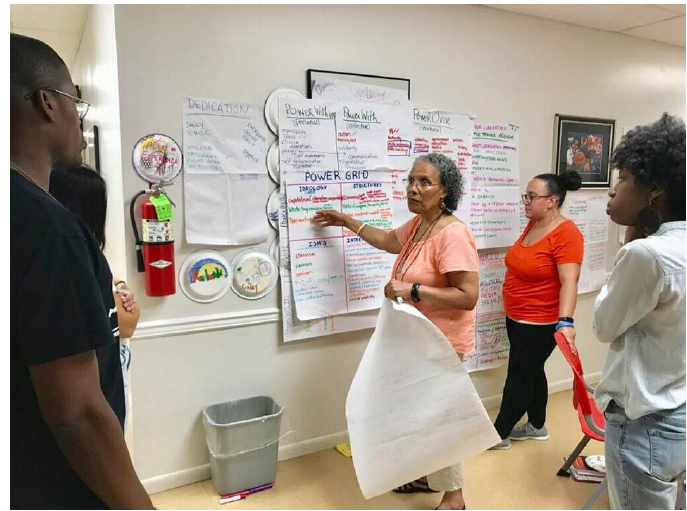
Figure 3. Facilitators, Esperanza Martell, Katheryn Crawford, Claude Copeland, and Stephanie Martinez, Esperanza preparing for an upcoming Education for Liberation Workshop at Casabe Houses, East Harlem. 19 September 2018.